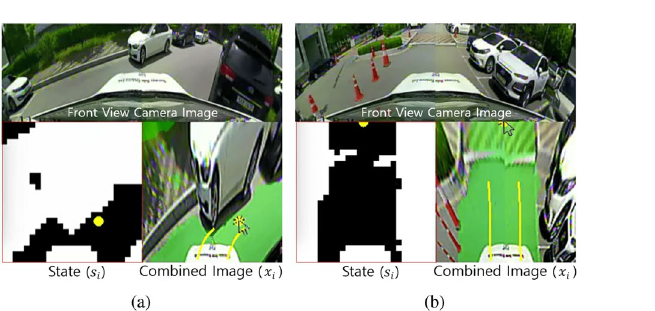
Figure 2. System architecture and deep neural network of the proposed methods.